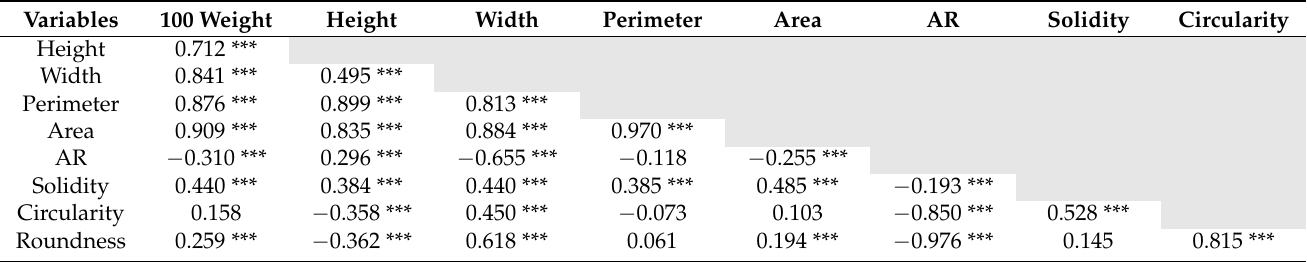
Table 1. Correlation analysis of morphological traits of soybean, 589 germplasms.